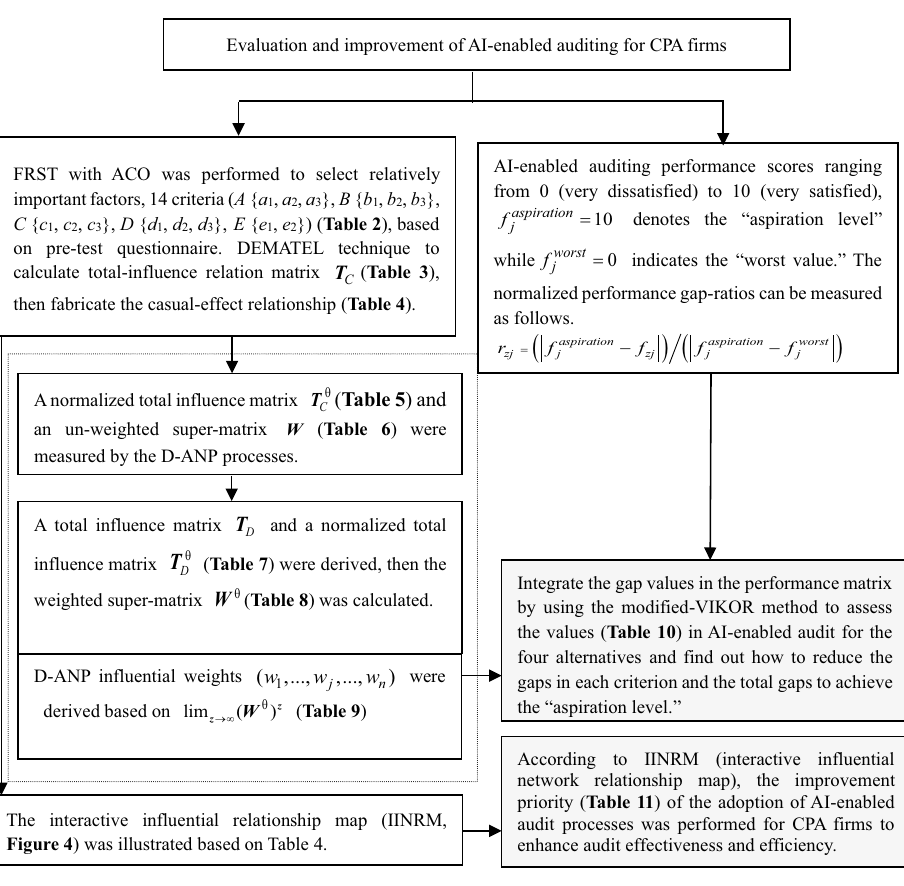
According to IINRM (interactive influential network relationship map), the improvement priority ( Table 11 ) of the adoption of AI-enabled audit processes was performed for CPA firms to enhance audit effectiveness and Figure 4. Process of the empirical case